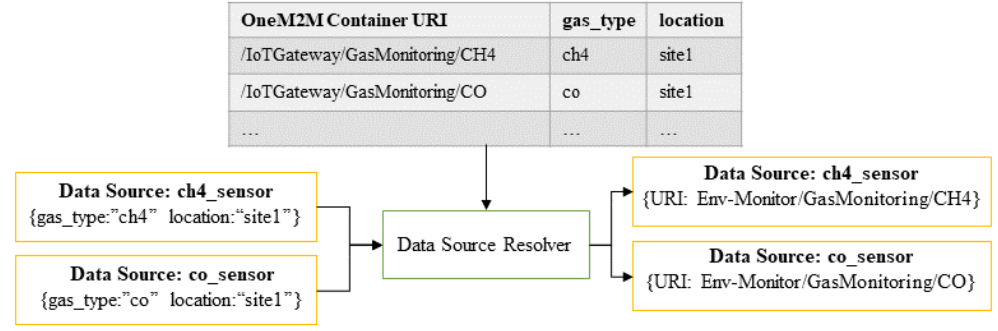
Figure 9. An illustration of data source